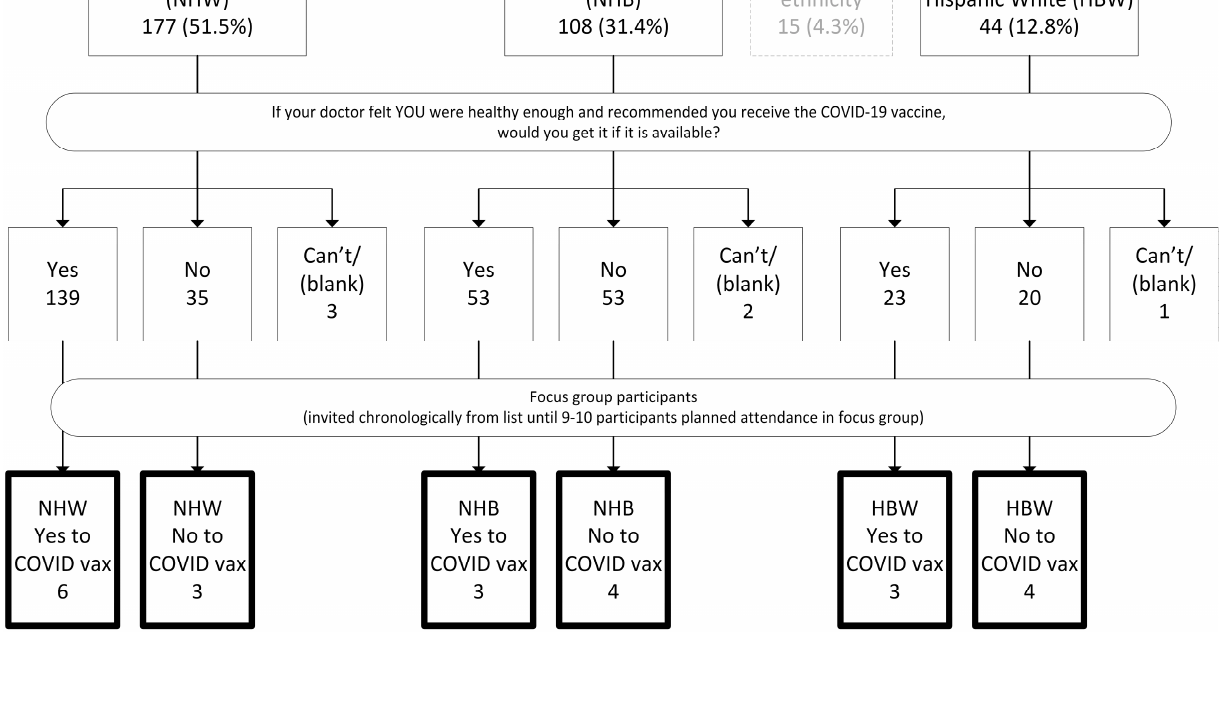
Figure 1. Survey and Focus Group Participant Flow Diagram. This flow diagram illustrates the number of eligible caregivers that initially consented for the survey, those that volunteered to be contacted for focus groups, and those that participated in focus